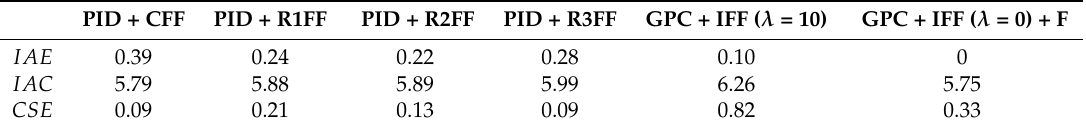
Table 2. Performance indexes for different configurations of PID and GPC feedforward control